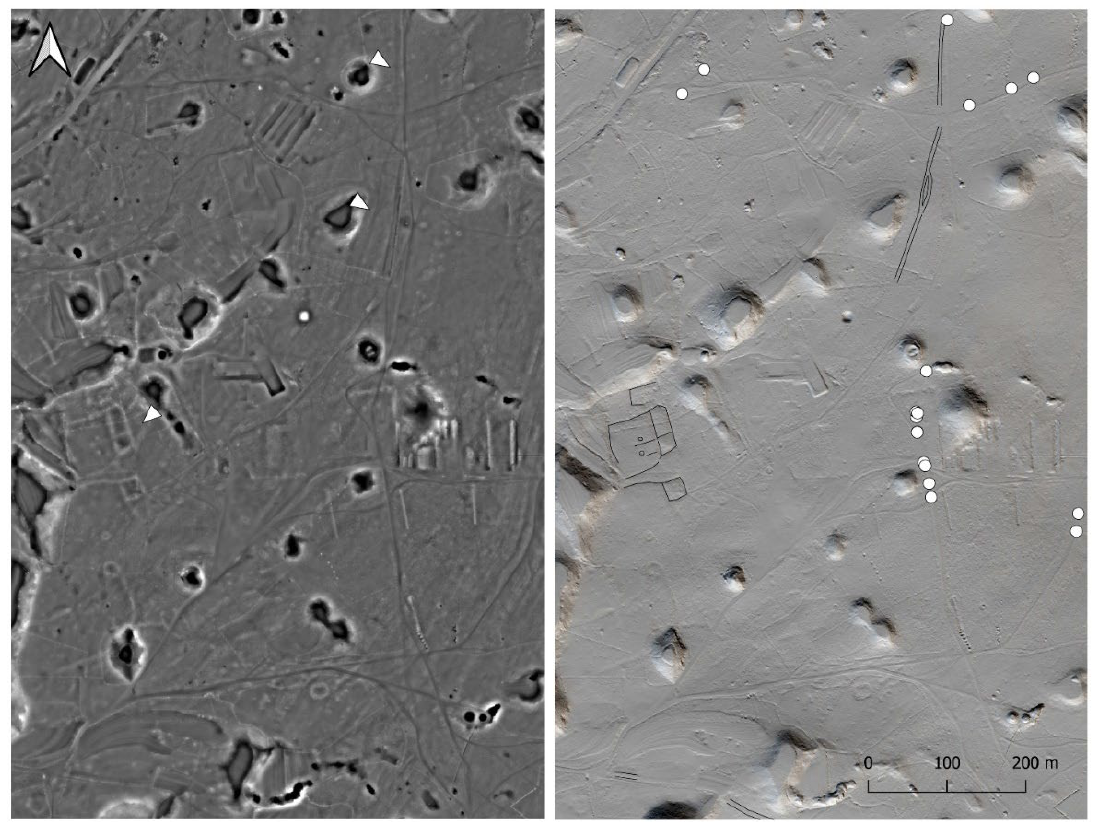
Figure 14. Zoomed view of area H of Figure 2 with the position of road tracks and a large rural complex indicated by white arrows in the left picture (local relief model of an ALS-derived DTM) and by black lines in the right one (hill-shaded image of an ALS-derived DTM). White circles: caliga hobnails.